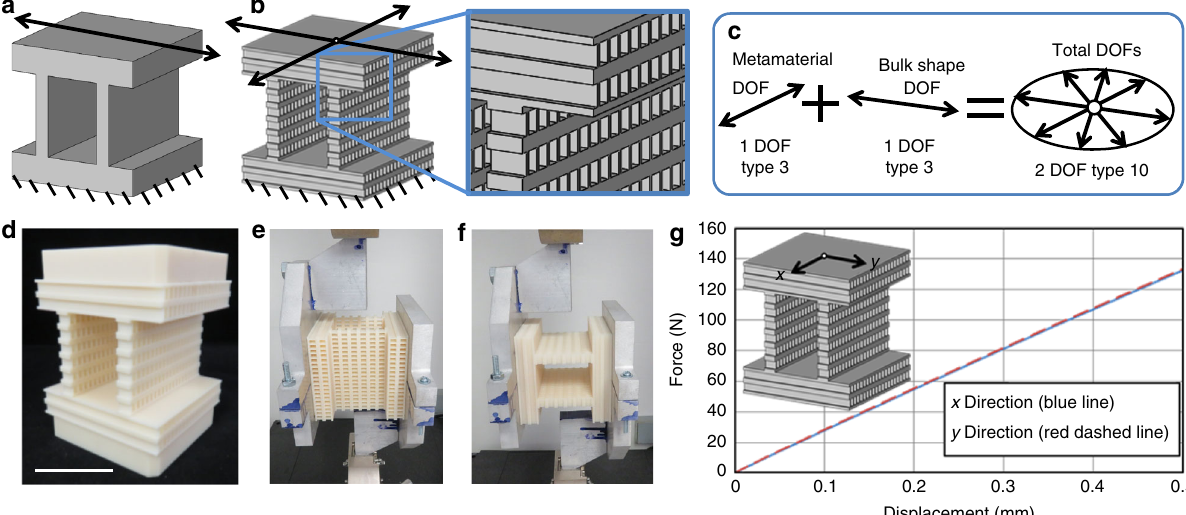
Fig. 9 Directionally compliant metamaterial (DCM) shape affects degrees of freedom (DOFs). a A bulk shape that achieves a translational DOF but would, b achieve two translational DOFs if the shape were rotated 90 o and used inside of itself. c The freedom space of a DCM results from the sum of its architecture ’ s freedom space and its bulk shape ’ s freedom space. d DCM was additively fabricated and, e , f tested in two different directions. g The stiffness in both directions are the same (scale bar in d , 5